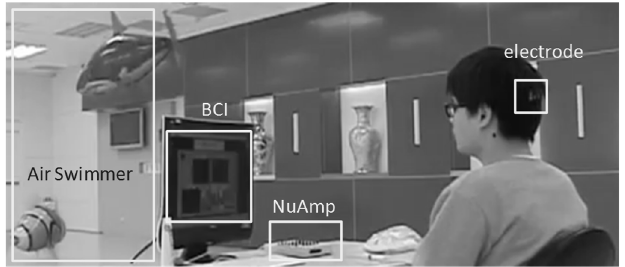
Figure 10. User controlling an air swimmer drone vehicle through the proposed approach.